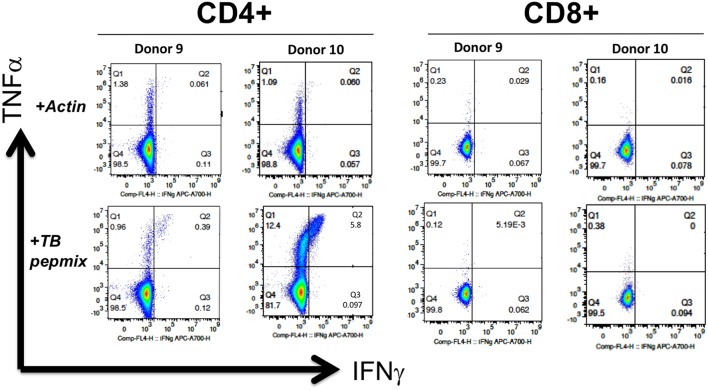
MSTs expanded from healthy donors are polyfunctional. Intracellular flow cytometry demonstrated production of IFN-γ and TNF in response to mycobacterial pepmix restimulation exclusively in CD4+ T cells from MSTs expanded from healthy donors, with no responses seen in CD8+ T cells.